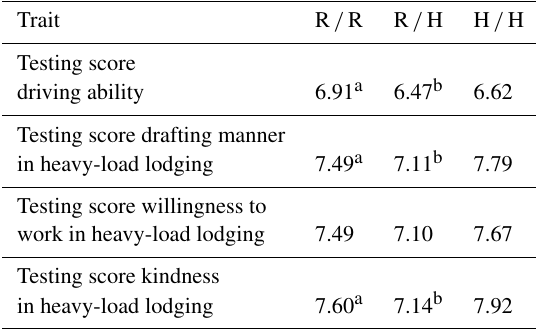
Table 2. Multiple comparisons of mean scores from the perfor- mance test in 169 Noriker stallions between homozygous glyco- gen synthase 1 gene mutation carriers H / H, heterozygous carriers R / H, and non-carrier stallions R / R in the testing block traits driv- ing ability, drafting manner in heavy-load lodging, willingness to work in heavy-load lodging, and kindness in heavy-load lodging.